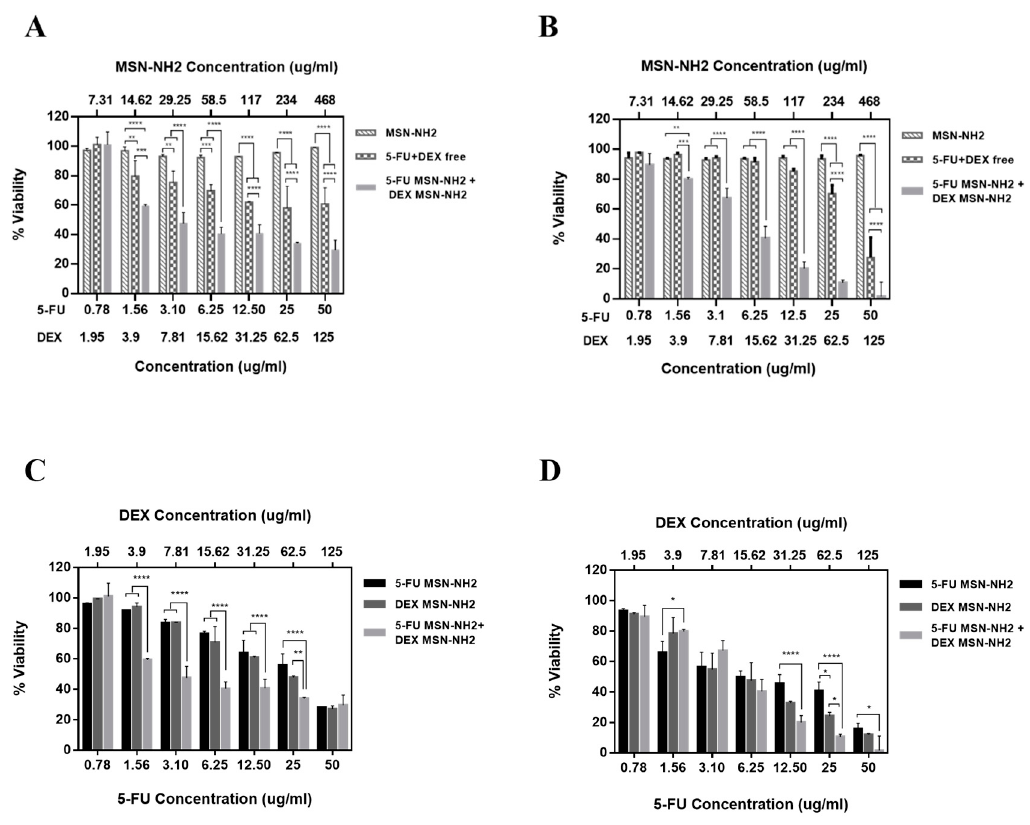
Figure 10. MSN-NH 2 -loaded 5-FU or DEX impairs the viability of HT-144 cells. Cytotoxicity of drug free MSN-NH 2 , 5-FU + DEX free, and 5-FU MSN-NH 2 + DEX MSN-NH 2 in HT-144 cells incubated for ( A ) 24 h and ( B ) 48 h. A comparison of the cytotoxicity between 5-FU MSN-NH 2 alone, DEX MSN-NH 2 alone, and 5-FU MSN-NH 2 + DEX MSN-NH 2 in HT-144 after incubation for ( C ) 24 h and ( D ) 48 h. Data are represented as mean ± SD ( n = 3). Statistical significance was obtained with p -values ≤ 0.05, where * p ≤ 0.05, ** p ≤ 0.01, *** p ≤ 0.001, and **** p < 0.0001